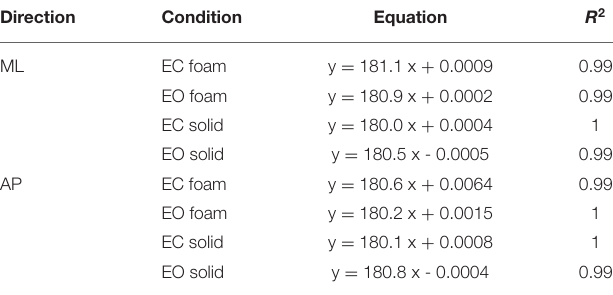
TABLE 6 | Relationship between CoP SD 2 and mean Spectrum Level in the adapted trial.